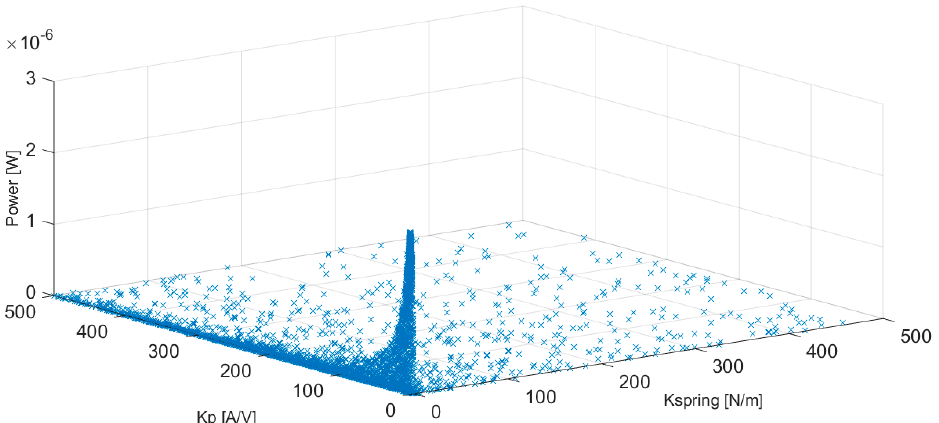
Figure 6. Progress of the JADE optimization algorithm. D = 10 mm circular cylinder-based harvester and Re = 3000.